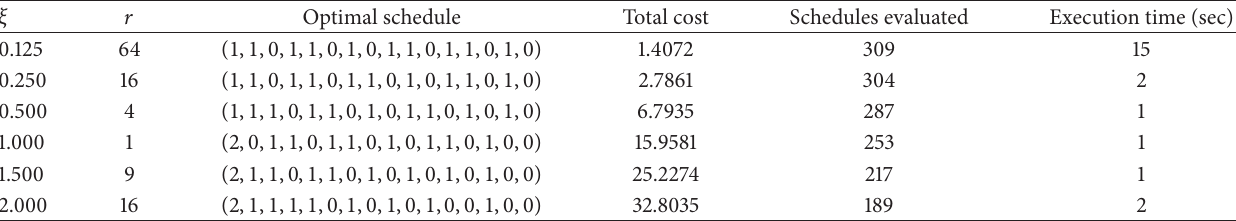
Table 1: Effect of service time